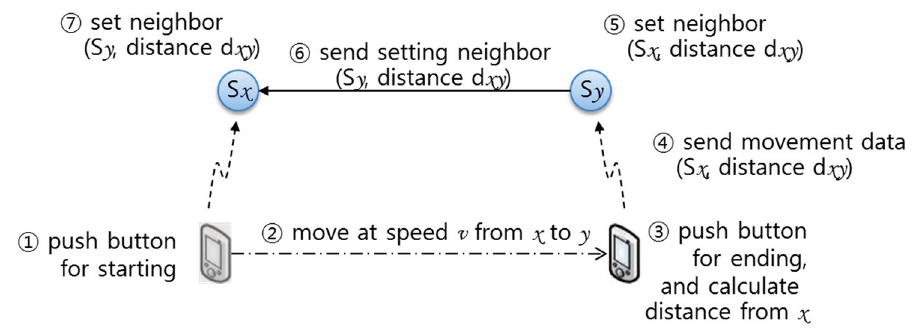
Figure 7. Manual method for connecting physical neighboring SLiM Hubs.